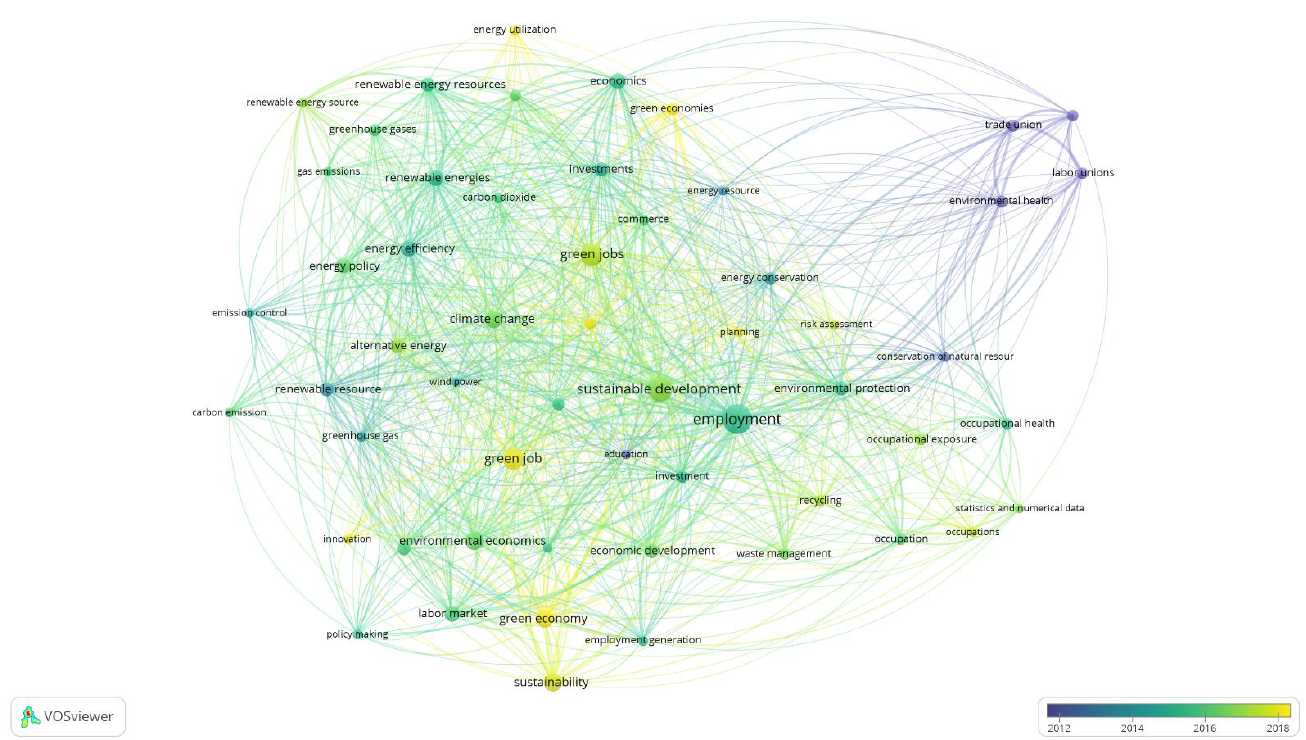
Figure 3. Overlay Visualization of keywords co-occurrences Q4 results analysis in Scopus. Source: Authors’ elaboration.